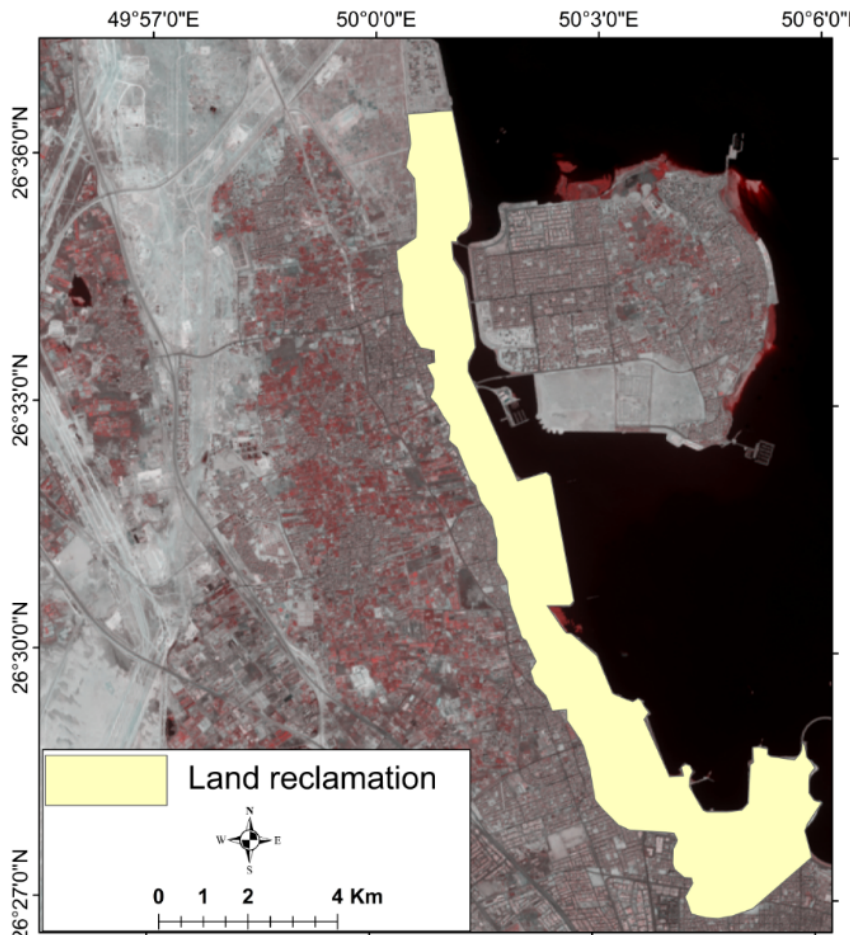
Figure 18. Map showing land reclamation in the study area.